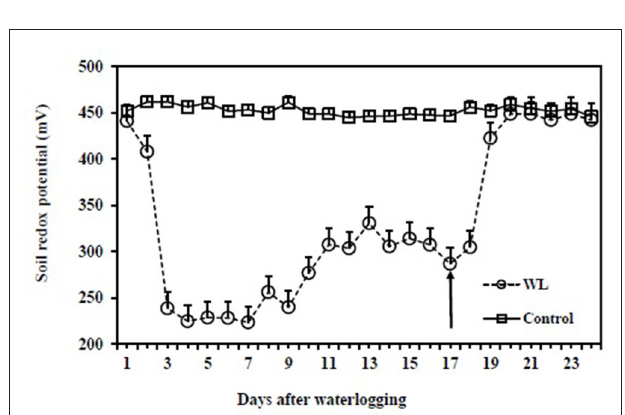
FIGURE 3 | Comparison of the soil redox potential of drained control and continuous waterlogging for 16 days followed by recovery upon drainage. The arrow represents the first day of recovery after the release of the waterlogging treatment. The vertical bars represent the means ± SE.